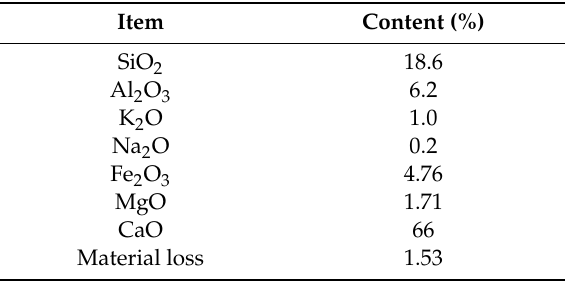
Table 3. Chemical composition of Portland cement.